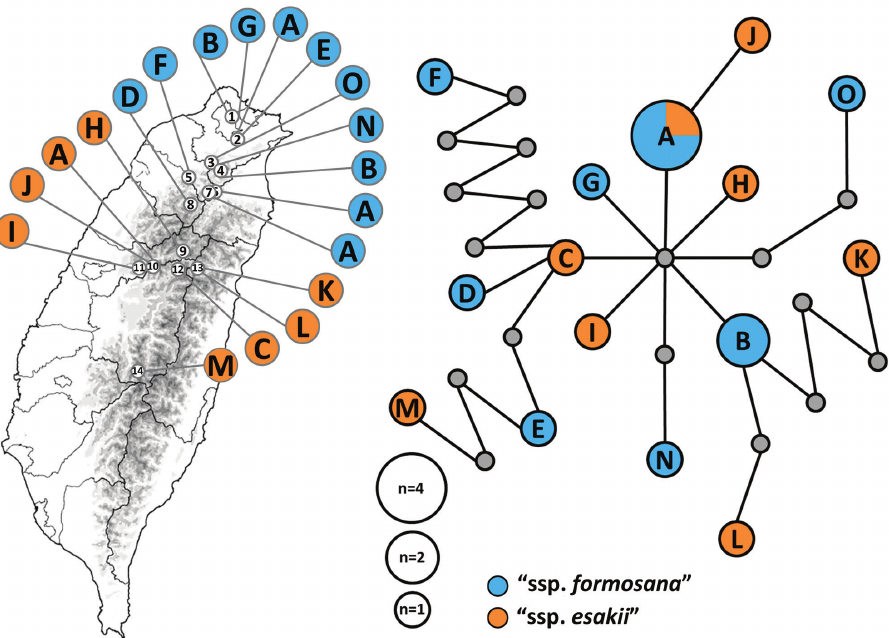
Figure 4. Haplotype network of Dodona butterfly in Taiwan. Blue circles represented ssp. formosana , whereas orange circles mentioned ssp. esakii